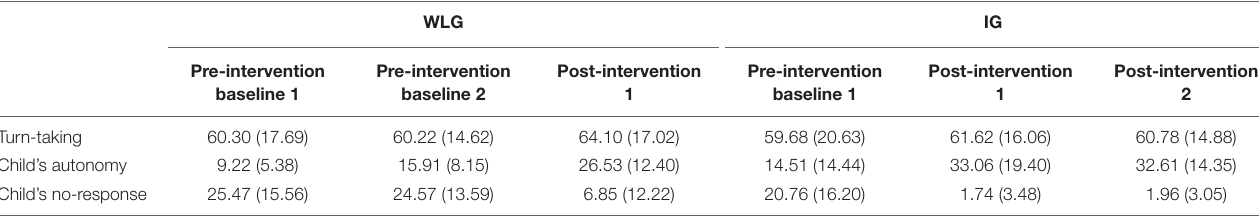
TABLE 2 | Mean (SD) for scores from the Tait video analysis for the three behavioral codes from the original protocol for the intervention-first group (IG, n = 9) and for the waiting-list group (WLG, n = 7) for double baseline pre- and double post-intervention sessions. WLG IG